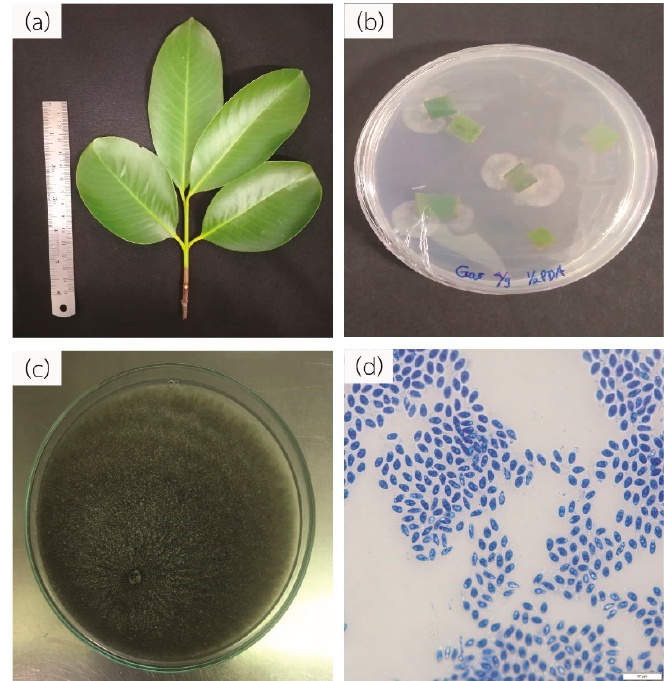
Figure 6. Overall endophytic fungi isolation. ( a ) Garcinia cowa Roxb. ex Choisy leaves. ( b ) Morphology of Phyllosticta sp . on half strength potato dextrose agar (PDA) and ( c ) yeast malt agar (YMA). ( d ) Morphology of Phyllosticta sp . spore. The scale bar represents 20 µm.